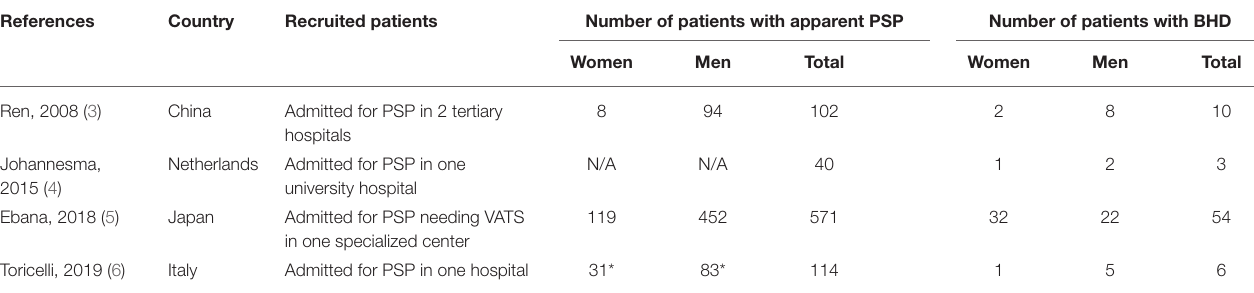
TABLE 1 | Studies reporting the number of patients with BHD among patients presenting with apparent primary spontaneous pneumothorax.